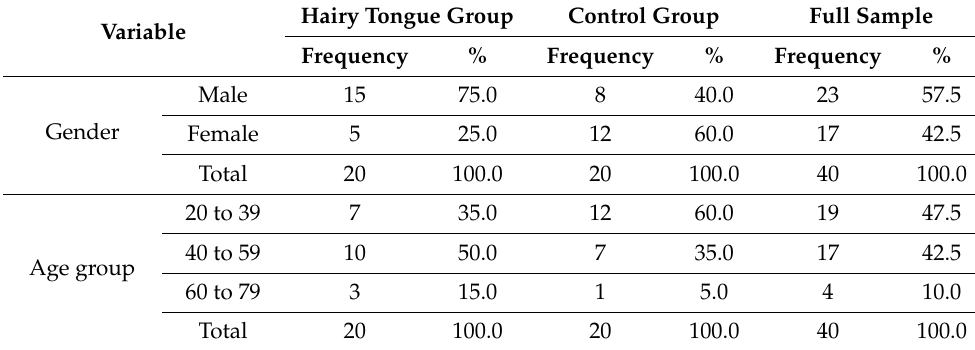
Table 1. Descriptive statistics of the demographic variables for the study sample (n =